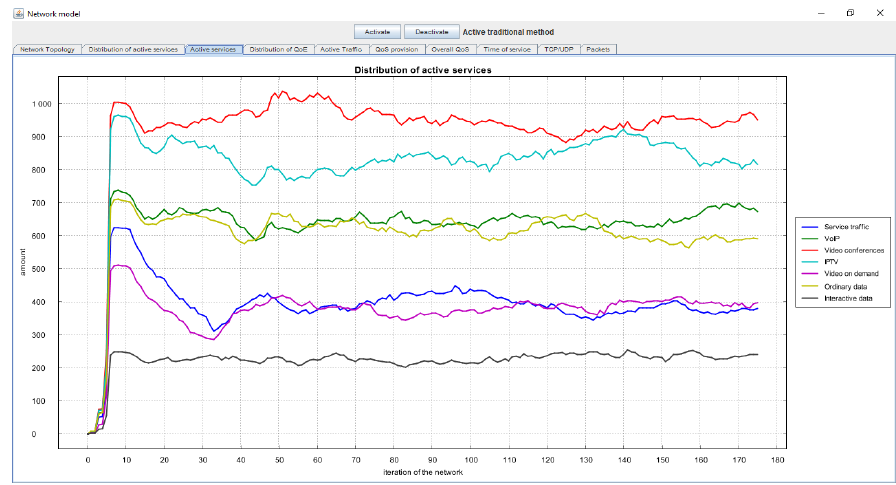
Figure 20. The active services distribution diagram.